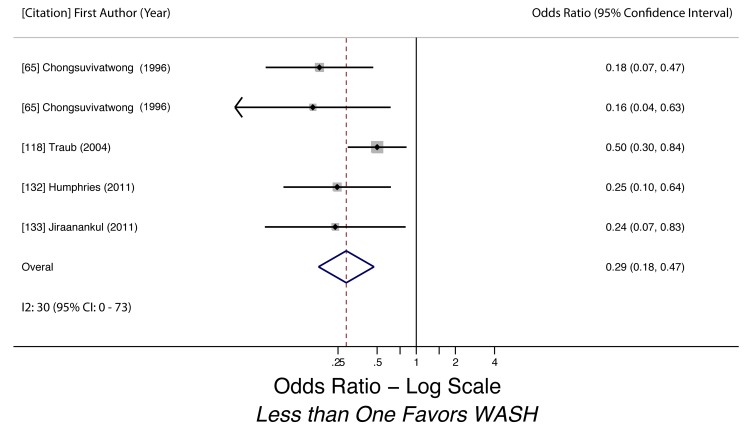
Meta-analysis of the association between wearing shoes and hookworm infection [65],[118],[132],[133]. Note: Chongsuvivatwong et al. [65] reported on two separate studies in their 1996 article.